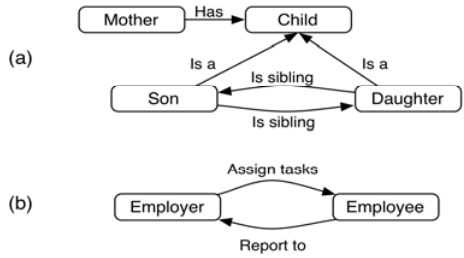
Fig. 1 Examples of reverse